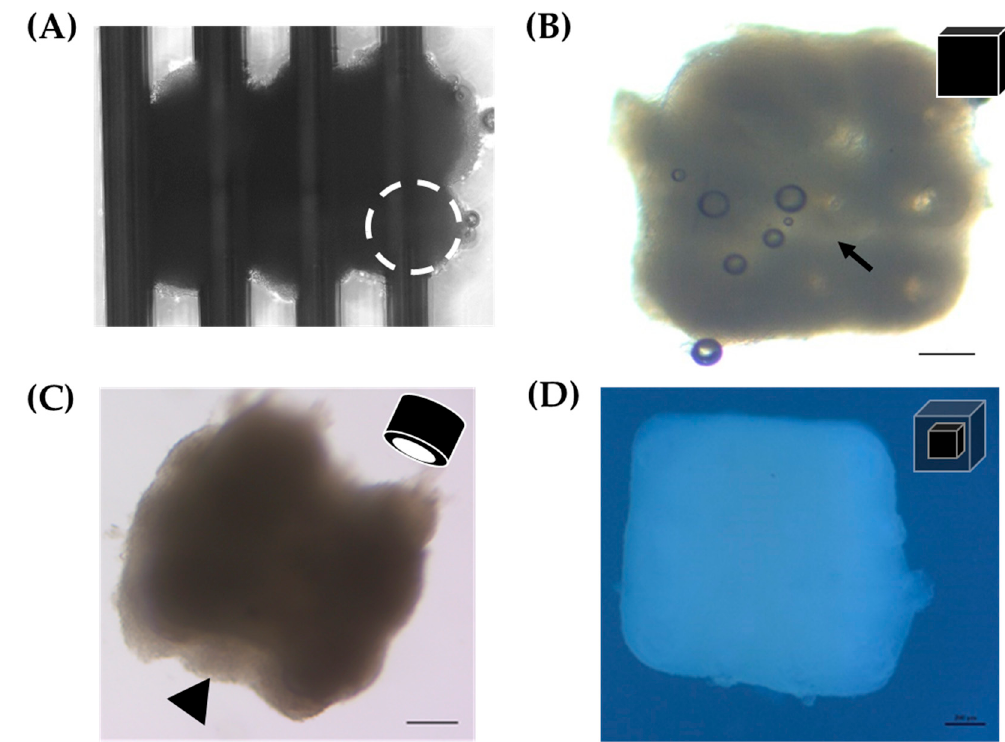
Figure 6. 3D biofabrication of 12Z and HEYA8 spheroids into constructs. ( A ) 12Z spheroids immediately after biofabrication in a 3 × 3 × 2 pattern on the Kenzan. White dotted circle = individual spheroid. ( B ) Rendering and representative example of the 3 × 3 × 2 3D biofabricated cube made from 12Z spheroids < 24 h after removal from Kenzan. Scale = 200 µ m. Arrow = hole left by Kenzan needle. ( C ) Rendering and representative example of a 3D printed tube made from 3 × 3 × 3 12Z spheroids > 24 h after removal from Kenzan. Scale = 200 µ m. Arrowhead = hollow channel. ( D ) Rendering and representative construct from a 2 × 2 × 2 HEYA8 core surrounded by a 4 × 4 × 4 12Z shell. Scale = 200 µ m.